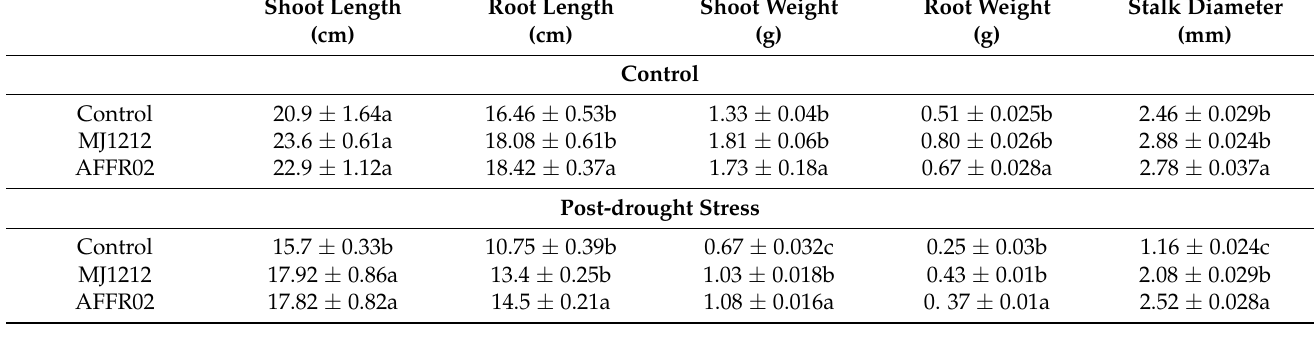
Table 1. Effect of isolate AFFR02 and MJ1212 on the growth attributes of alfalfa plants under normal and post-drought stress conditions. Each value in the table is the mean ± standard deviation of three replicates. Mean in columns followed by different letters describes significant difference by using Duncan’s multiple range test at p > 0.05.